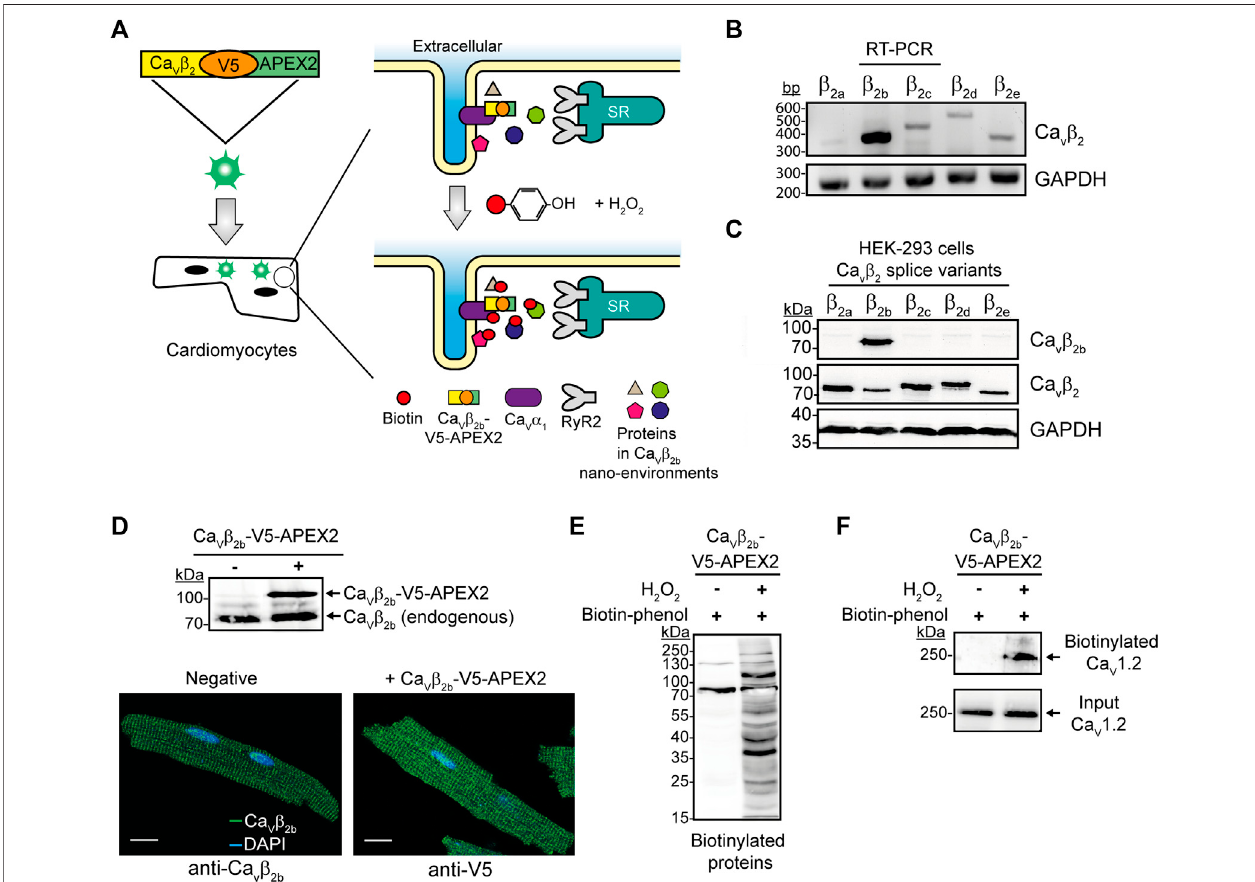
FIGURE 1 | APEX2-mediated proximity biotinylation for the identi fi cation of proteins in the Ca v β 2b nanoenvironments in cardiomyocytes. (A) Schematic representationoftheAPEX2-mediatedproximitybiotinylationwork fl ow.ARCsweretransducedwiththeconstructCa v β 2b -V5-APEX2usinganadenoviralvector.APEX2 fused to Ca v β 2b enables the biotin labeling of proteins located within a 20-nm radius of Ca v β 2b when the substrates biotin-phenol and H 2 O 2 are present. Biotinylated proteins are further enriched by streptavidin-coated beads through af fi nity puri fi cation and bound proteins are analyzed by mass spectrometry. (B) RT-PCR analysis of the expression pattern of the fi ve Ca v β 2 splice variants (Ca v β 2a -Ca v β 2e ) in ARCs. GAPDH was used as control. (C) Western blot analyses to validate the speci fi city of the anti-Ca v β 2b antibody using lysates from HEK-293 cells overexpressing the different Ca v β 2 splice variants. A commercial anti-Ca v β 2 and an anti-GAPDH antibodieswere used asexpression and loadingcontrols, respectively. (D) Western blot analysisofCa v β 2b -V5-APEX2 expression inARCs (i) and confocal fl uorescence imagesofARCsexpressing ornotCa v β 2b -V5-APEX2andvisualizedusinganti-Ca v β 2b and anti-V5antibodiestorecognizetheendogenousandtherecombinantCa v β 2b proteins, respectively (ii) . Scale bar represents 15 μ m. (E) Streptavidin blot analysis of endogenous proteins biotinylated by Ca v β 2b -V5-APEX2 in ARCs. (F) Biotinylation of Ca v 1.2 by Ca v β 2b -V5-APEX2. Western blot analysis using an anti-Ca v 1.2 antibody after streptavidin-mediated enrichment of biotinylated proteins. All the data shown are representative of three independent experiments. APEX2, ascorbate peroxidase; ARCs, adult rat cardiomyocytes; RyR2, ryanodine receptor 2; bp, base pairs.